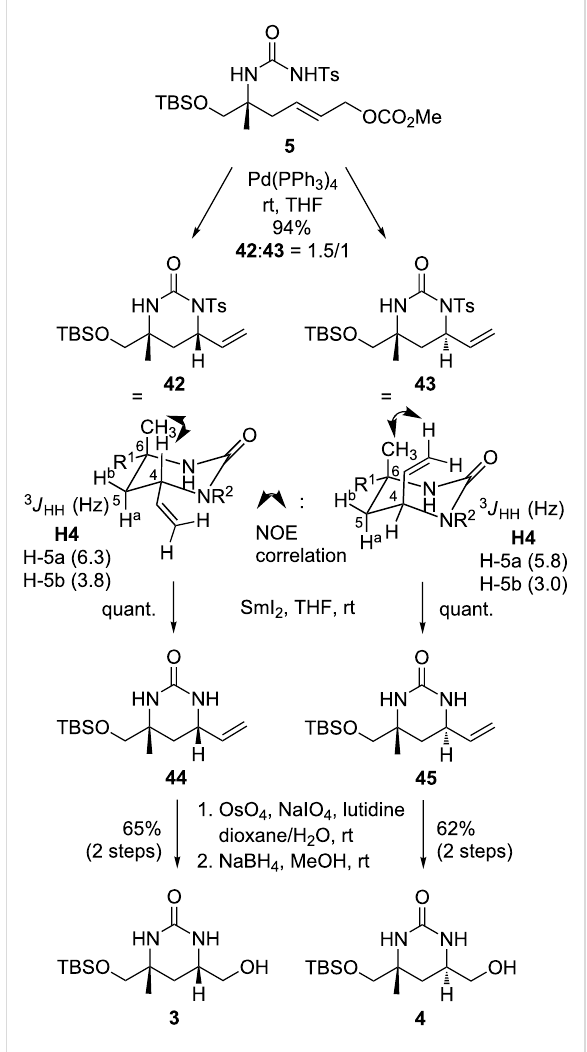
Scheme 7: Divergent Tsuji–Trost coupling and completion of the syn- thesis of authentic pyrimidinones 3 and 4 .